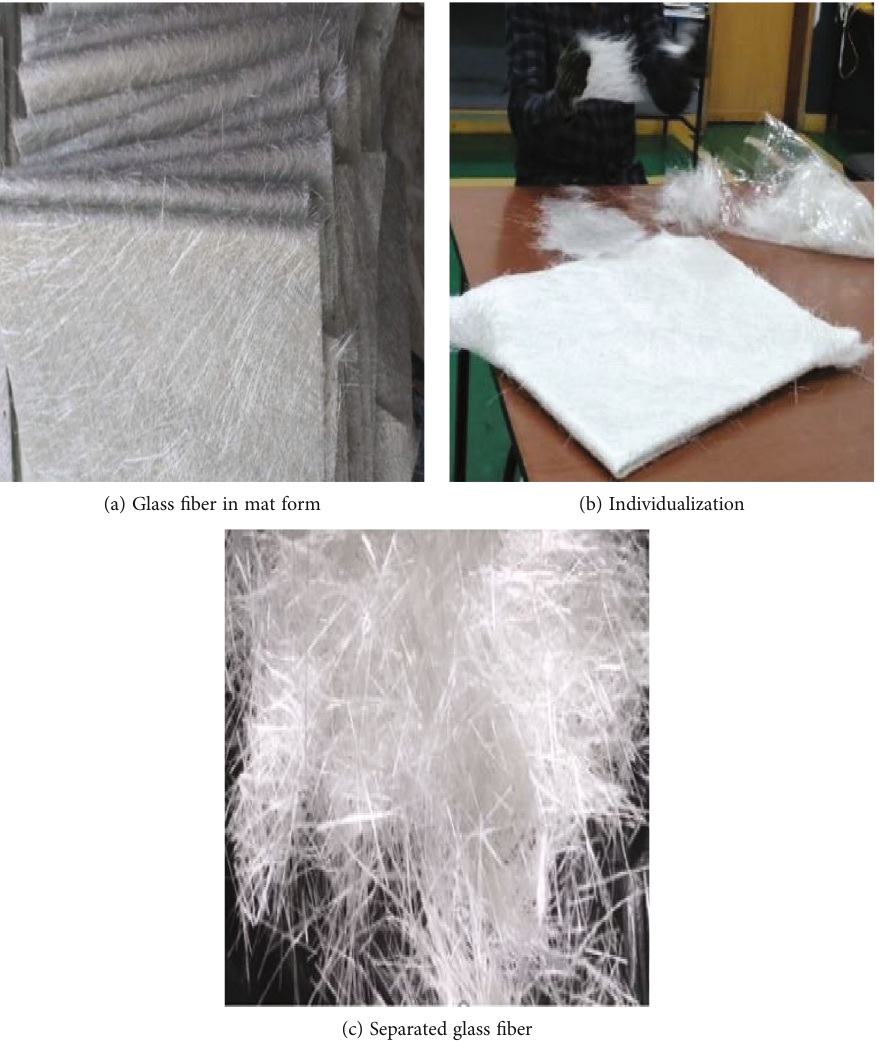
Figure 3: Glass fi ber individualization